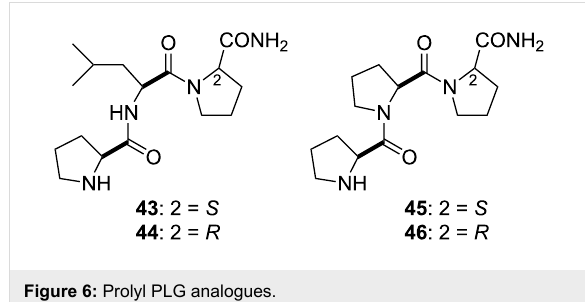
Figure 6: Prolyl PLG